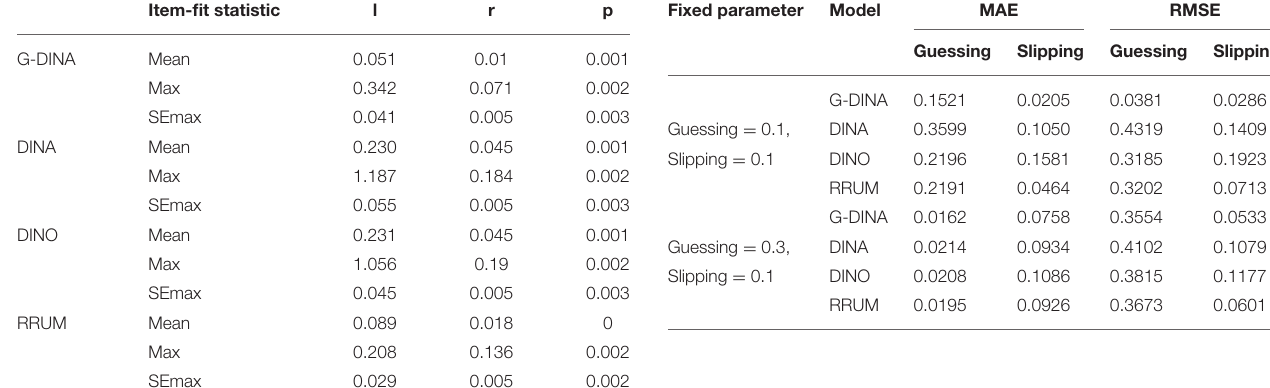
TABLE 5 | Item-fit statistic based on four cognitive diagnosis models. Item-fit statistic